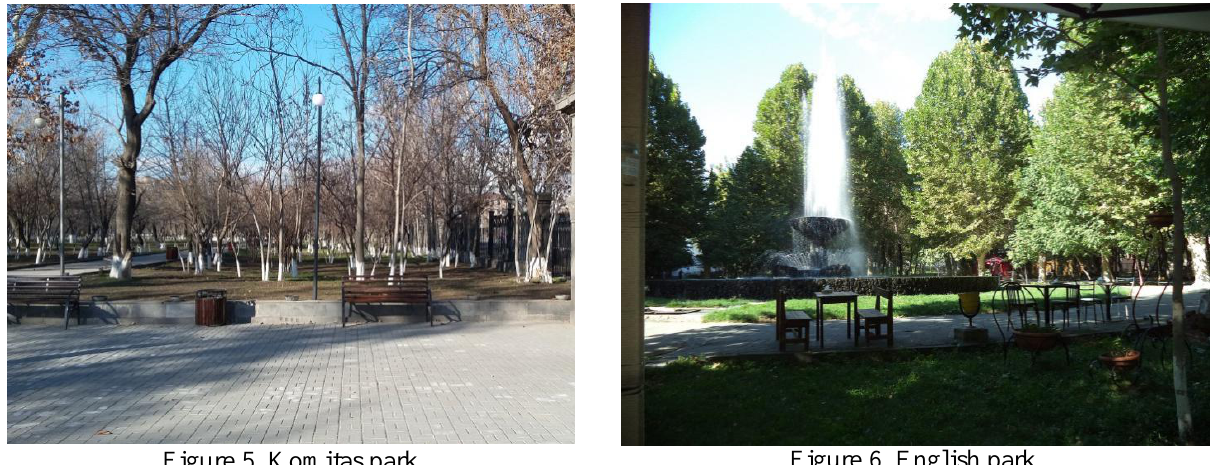
Figure 5. Komitas park Figure 6. English park